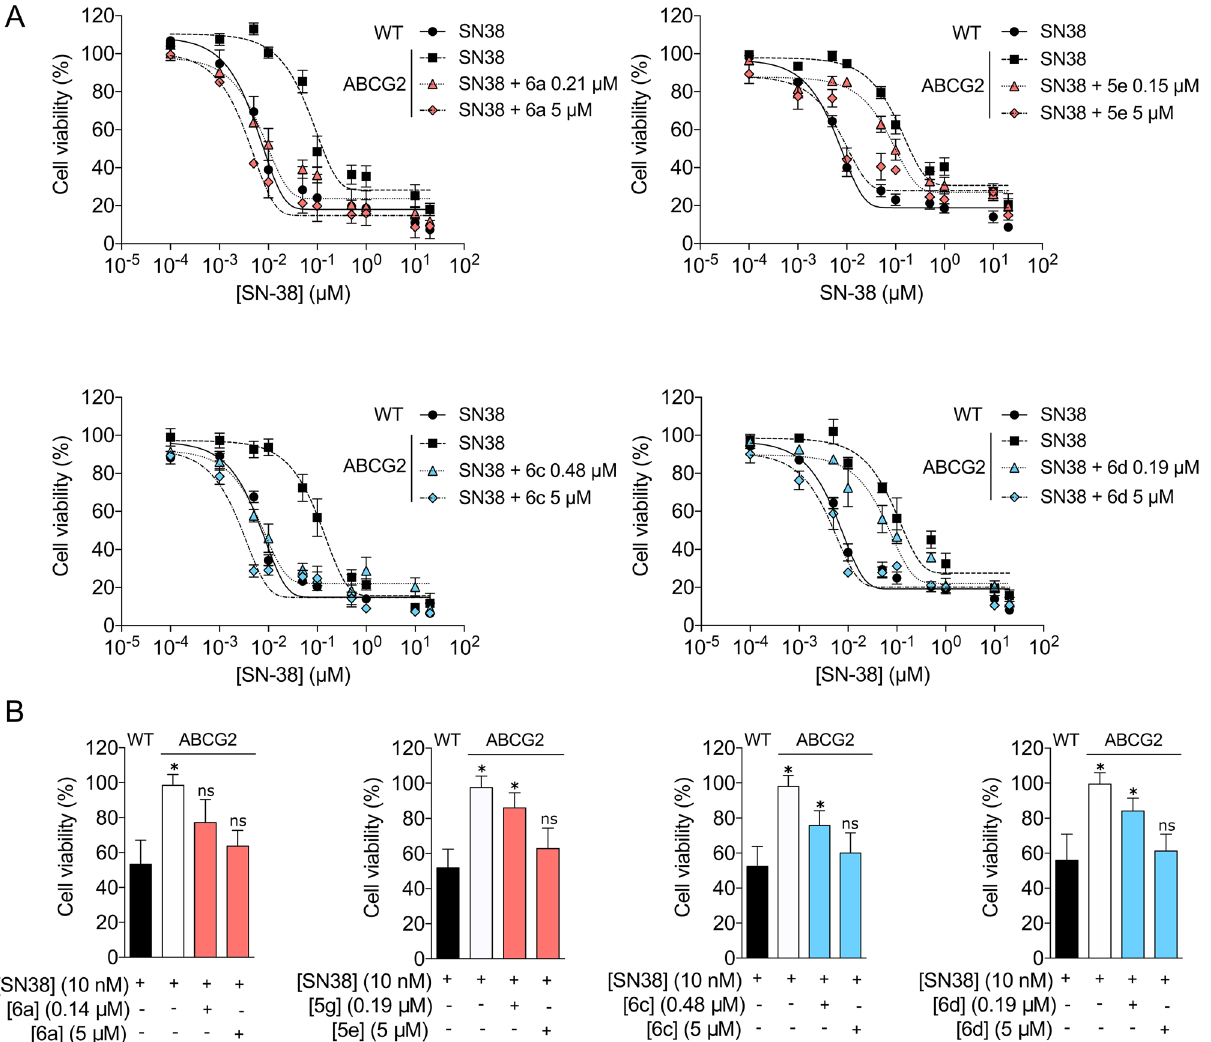
Figure 4. Sensitization of transfected and cancer cells overexpressing ABCG2 to SN-38. Cell viability was determined by MTT assay. ( A ) Cell viability of HEK293- ABCG2 and HEK293 (wild-type) control cells upon 72 h treatment with SN-38 at increasing concentrations, as indicated, and HEK293- ABCG2 cells upon co-treatment with SN-38 and inhibitors at either IC 50 values or 5 µM. ( B ) Cell viability of H460MX20 and H460 control cells upon 72 h treatment with SN-38 at 10 nM, as indicated, and H460MX20 cells upon co-treatment with SN-38 and inhibitors at either IC 50 values or 5 µM. The data are the mean ± SEM of three independent experiments performed in triplicate and compared using the Student’s t test (2-sided) for independent samples. * p < 0.05 were considered significant for all compounds in the drug-binding pocket of ABCG2 promotes conformational changes affecting ATPase activity, but these conformational changes do not affect the extracellular loops recognized by the 5D3 antibody. Bimodulation and thermostabilization assays. As previously described, the compounds were classi- fied as either complete (I MAX ≥ 80%) or partial inhibitors (I MAX ≤ 80%). Partial inhibition at a saturating concen- tration allows the combination of these inhibitors ( 6a , 5e ) with complete inhibitors ( 6c , 6d ) to check for additive or antagonistic effects. As shown in Fig. 6C, all possible combinations decrease the maximal inhibition, indi- cating a possible antagonism effect between the indeno[1,2- b ]indole derivatives. The decrease in the maximal inhibition was more evident when combining a partial and a complete inhibitor (purple bars). Since a partial inhibitor moderately suppresses the effect of a complete inhibitor, we hypothesize that compounds 6a and 5e may prefer to bind at sites that overlap with the binding sites of the complete inhibitors 6c and 6d . The thermal stability assay showed that the indeno[1,2- b ]indole derivatives trigger ABCG2 conformational changes stabilizing the protein structure (Fig. 6D). The partial inhibitors ( 5e and 6a ) presented a moderate effect compared to complete inhibitors ( 6c and 6d ). This effect can be observed by comparing the IT 50 (temperature that reduces 50% of the ATPase activity) values from curves with or without ATP (Fig. 6D). For complete inhibitors,